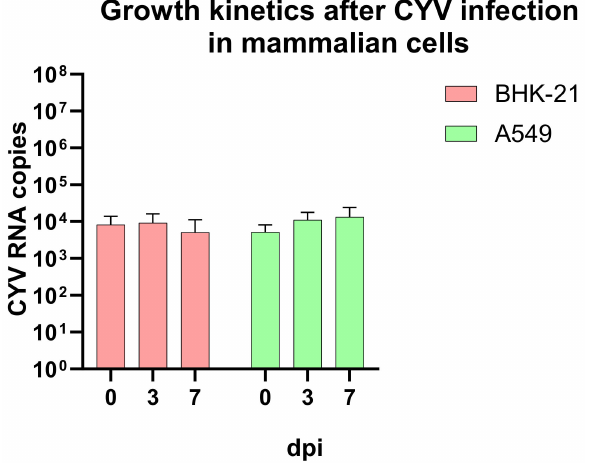
Figure 7. Viral growth kinetics of CYV in different mammalian cell lines. BHK-21 (red) and A549 (green) cells were inoculated with an infection volume of 2.5 µ L of CYV displayed with SD. Samples were taken on days zero, three, and seven; dpi = days